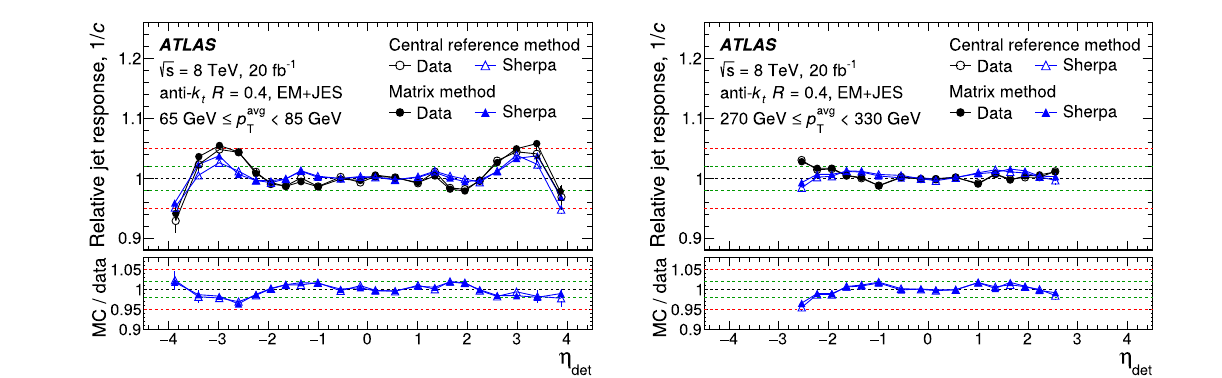
Fig. 16 Relative jet response measured using the matrix and central for data (circles) and Sherpa (triangles) using the central reference method (empty symbols) and the matrix method (filled symbols). Only reference methods for anti- k t jets with R = 0 . 4 calibrated with the statistical uncertainties are shown. The dashed lines in the lower panels EM+JES scheme as a function of the probe jet pseudorapidity. Results < 85GeVand270GeV ≤ p avg < 330GeV indicate 1 ± 0 . 02 and 1 ± 0 . 05 arepresentedfor65GeV ≤ p avg T T